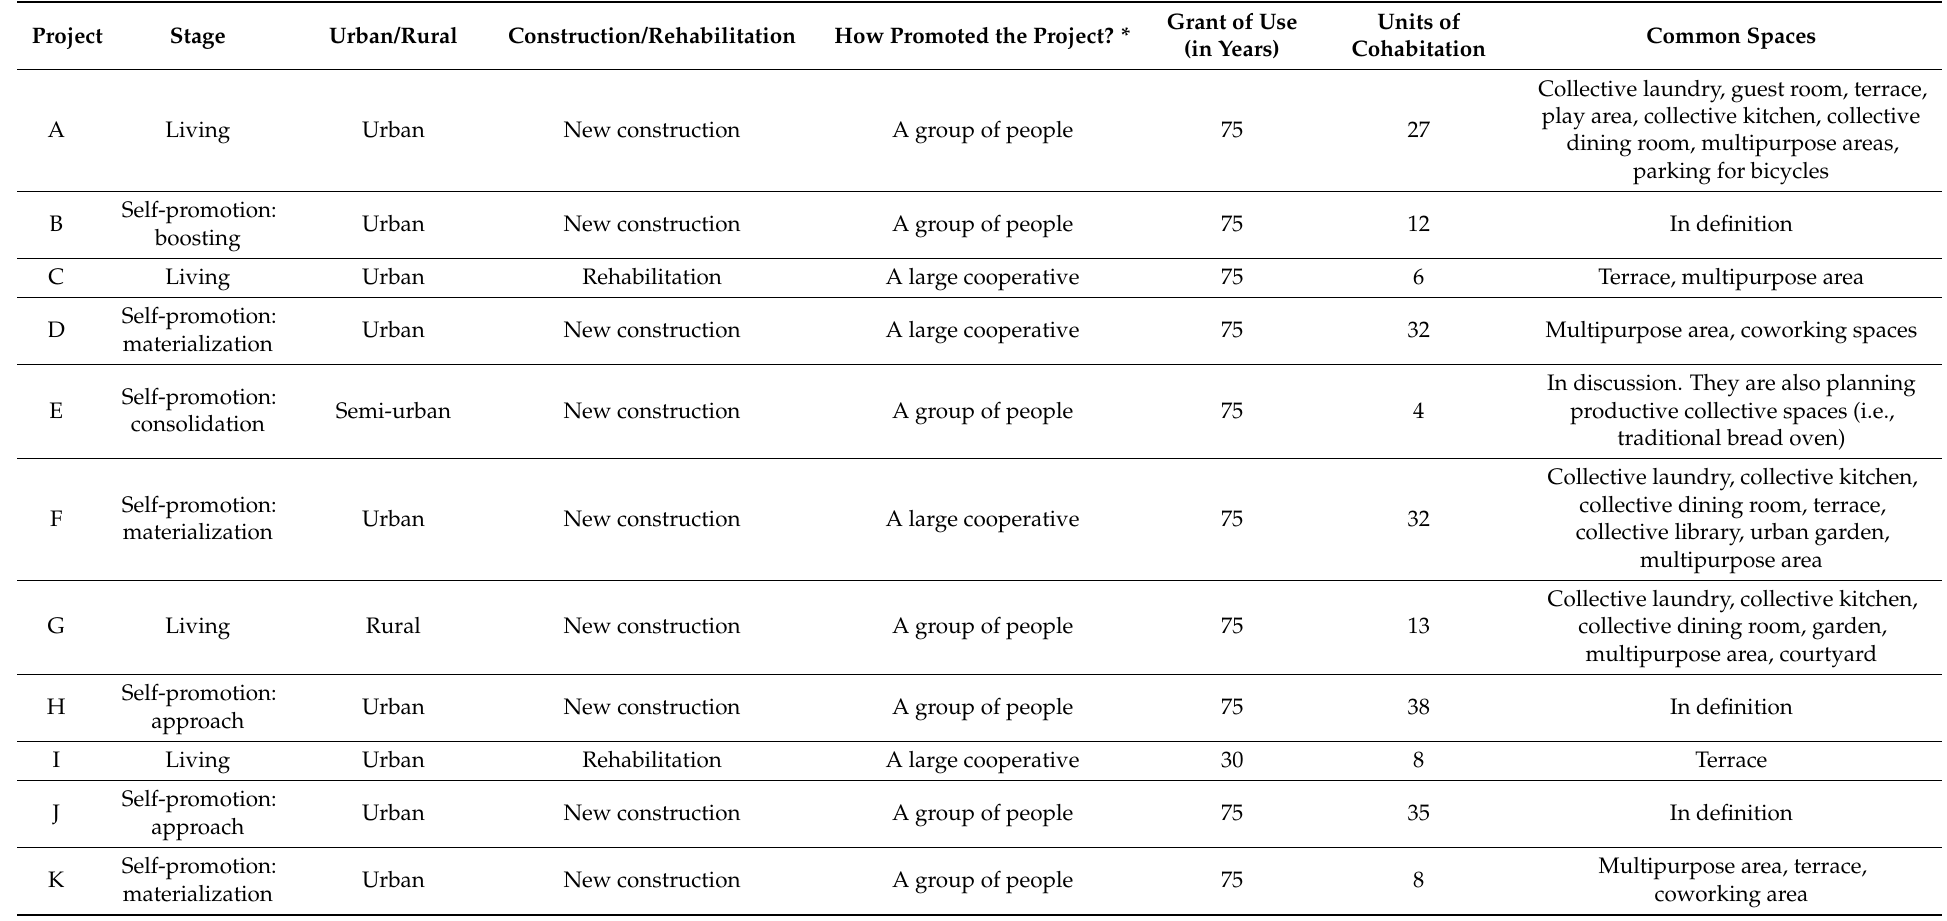
Table 1. Summary of the characteristics of the cooperative housing under GoU model projects (elaborated by authors